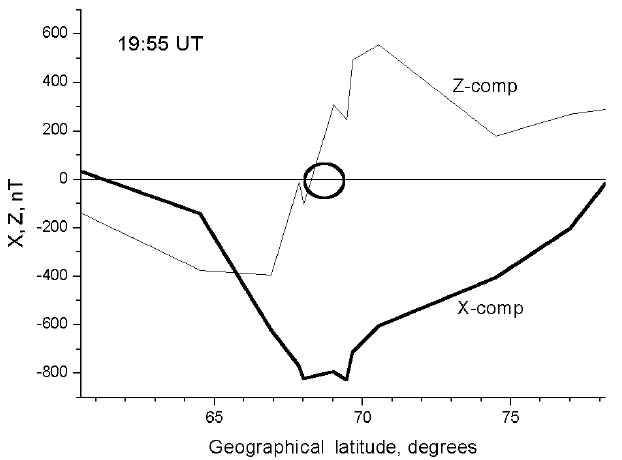
Figure 3 . X - Z latitudinal profiles obtained from IMAGE magnetometers on 2 October 1998, Fig. 3. X − Z latitudinal profiles obtained from IMAGE magne- at 19.55 UT. The spatial position of the heated patch at the altitude of 300 km is depicted by a tometers on 2 October 1998, at 19:55 UT. The spatial position of circle. the heated patch at the altitude of 300km is depicted by a circle.